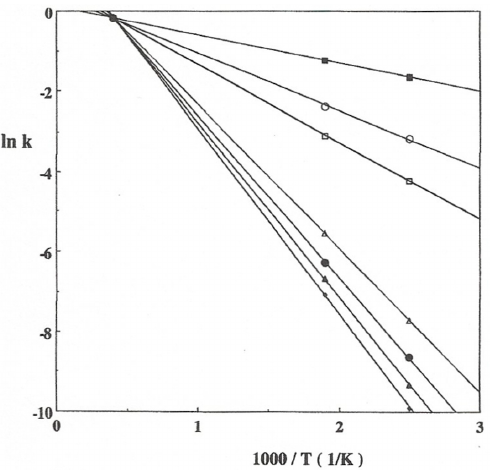
Figure 2. Arrhenius lines for the reaction between carbon dioxide and lanthanide atoms. This relationship [24] holds for the seven elements from samarium up to and including erbium. (With the courtesy by Springer